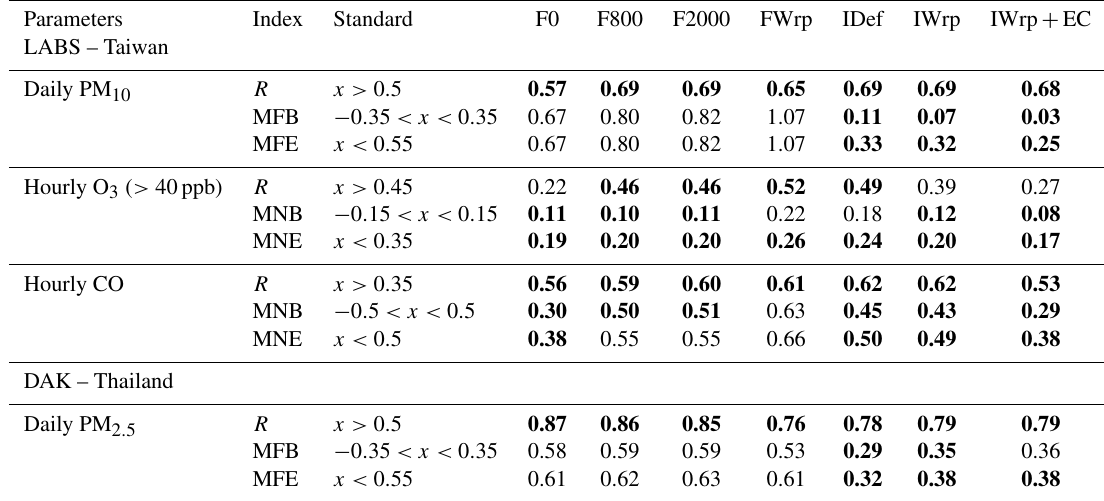
Table 3. Performance of modeled chemistry field with different settings of PLMRIM at a mountain site in the western North Pacific (LABS) and nPSEA (DAK). R: correlation coefficient; MFB: mean fractional bias; MFE: mean fractional error; MNB: mean normalized bias; MNE: mean normalized error. Bold values are model output that satisfied the standard of each